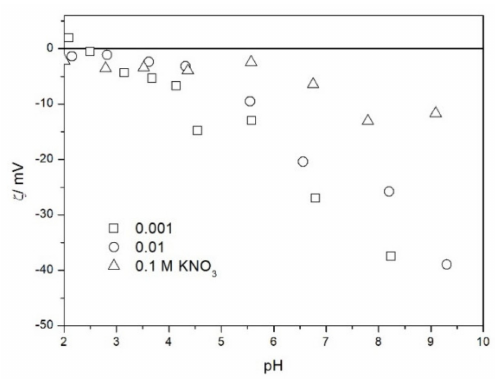
Figure 5. The zeta potential of TeO 2 in KNO 3 .